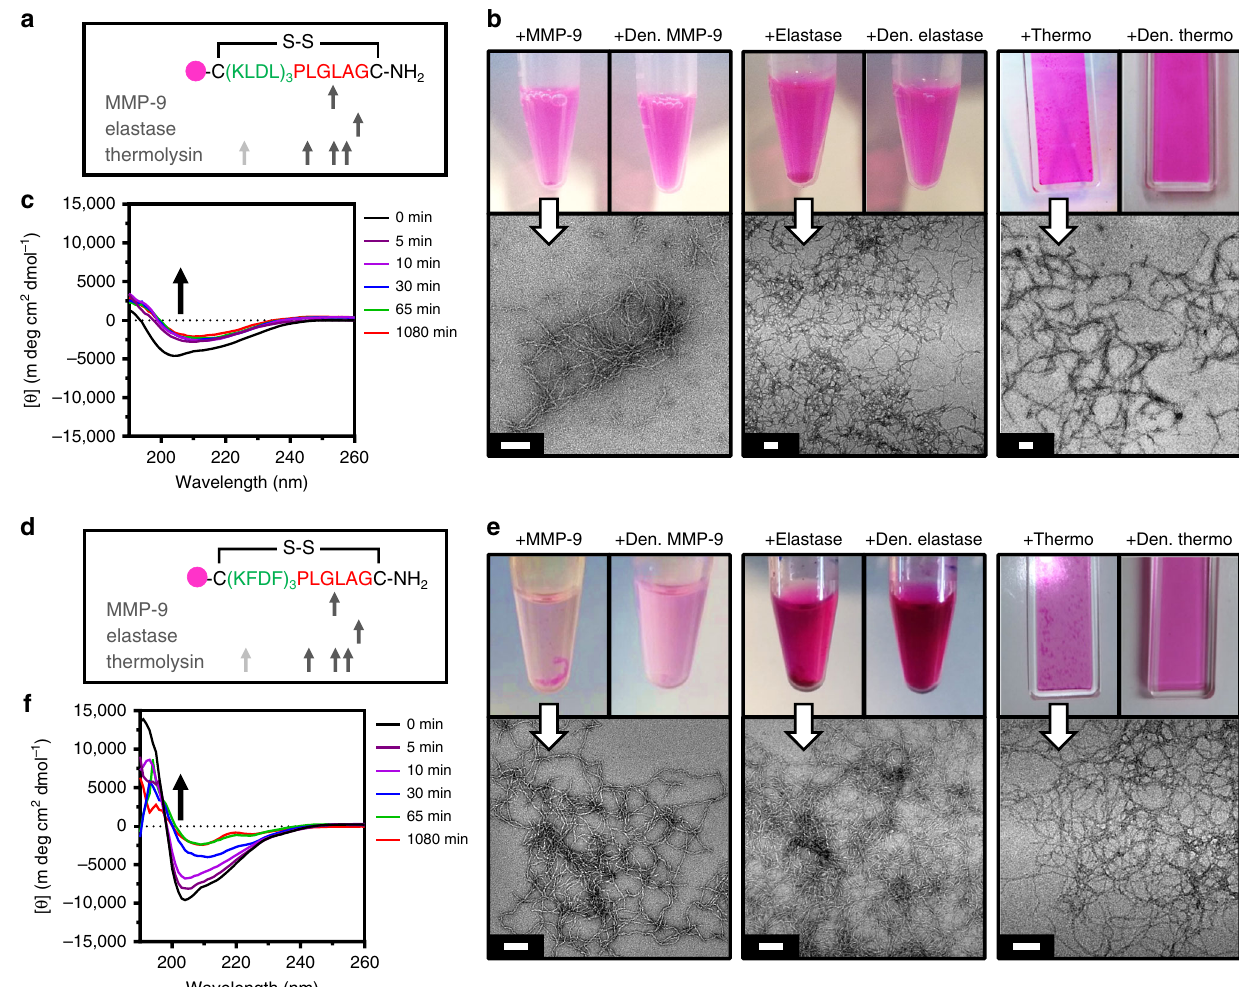
Fig. 5 Enzyme responsiveness of Rho-KLDL Cyclic and Rho-KFDF Cyclic progelators. a – c Analysis of Rho-KLDL Cyclic responsiveness to matrix metalloproteinase-9 (MMP-9), elastase, and thermolysin. a Peptide sequence and theoretical enzymatic cuts sites. Gray arrow (not observed). b Photographs (top) of progelator incubated with active enzymes (left insets) shows material aggregation and settling from solution, and progelator incubated with denatured enzymes (right insets) show fully dispersed peptide solutions. Corresponding transmission electron microscopy (TEM) images (bottom) of active enzyme cleavage products show fi ber formation. Scale 100 nm. c Circular dichroism (CD) spectra of cleavage kinetics with thermolysin. Disappearance of signal at 204 nm (black arrow), corresponds to ring-opening. d – f Analysis of Rho-KFDF Cyclic to responsiveness MMP-9, elastase, and thermolysin. d Peptide sequence and theoretical enzymatic cuts sites. Gray arrow (not observed). e Photographs (top) of progelator incubated with active enzymes (left insets) shows material aggregation and settling from solution, and progelator incubated with denatured enzymes (right insets) show fully dispersed peptide solutions. Corresponding TEM images (bottom) of active enzyme cleavage products show fi ber formation. Scale 100 nm. f CD spectra of cleavage kinetics with thermolysin. Disappearance of signal at 204 nm (black arrow) corresponds to ring opening. CD of 500 µ M progelator in 10 mM Tris buffer, pH 7.4. Enzyme cleavages performed at 500 µ M progelator with 1:1000, 1:250, and 1:4500 enzyme/substrate molar ratio in 1× cleavage buffers (see Methods). Samples diluted to 100 µ M for of excess strain (100%) (Fig. 6b, c). Morphological changes from rheology samples before and after enzyme incubation are illu- strated in Fig. 6d, e. Synthetic product analog SAPs in which the sequence (KLDL Control and KFDF Control ) were used for simple comparison with enzyme-induced gelation (Supplementary Figs. 15-16).